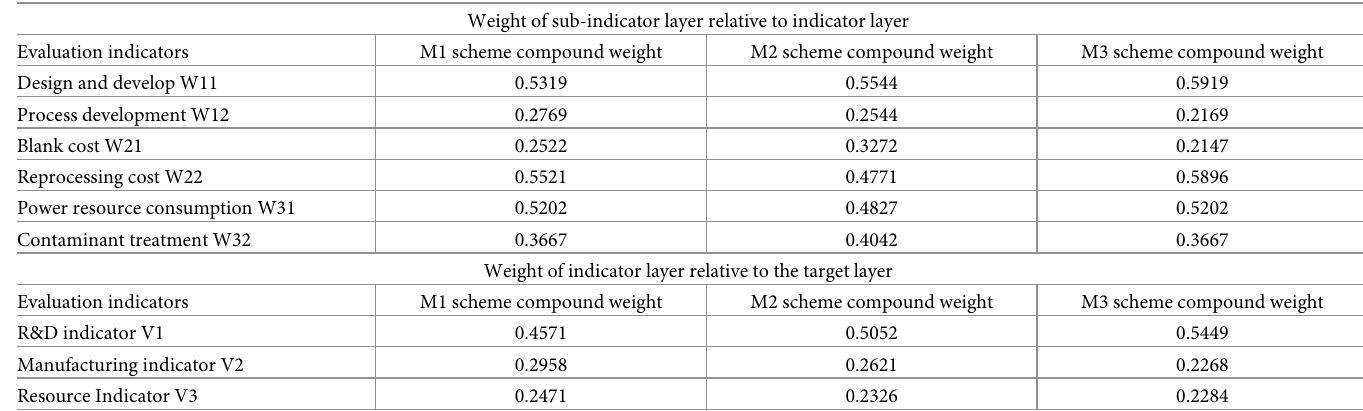
Weight of sub-indicator layer relative to indicator layer